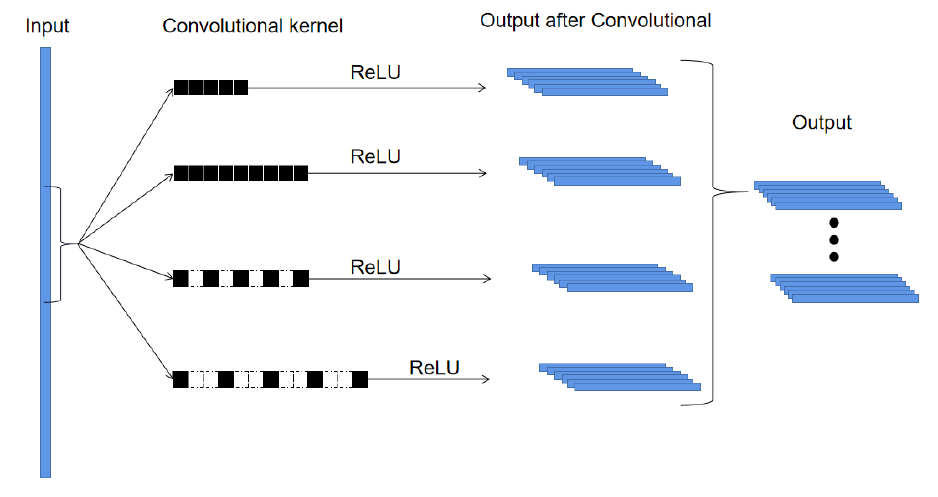
Figure 4. Structure of DMSConv layer.